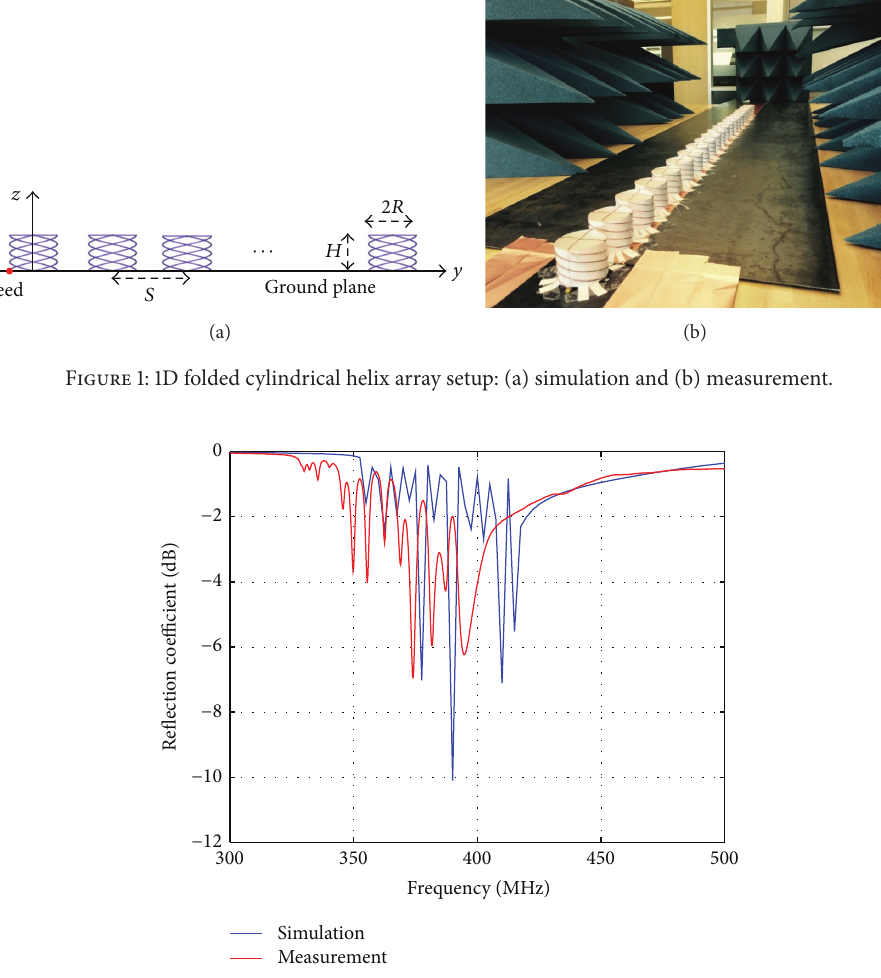
Figure 2: Simulated and measured reflection